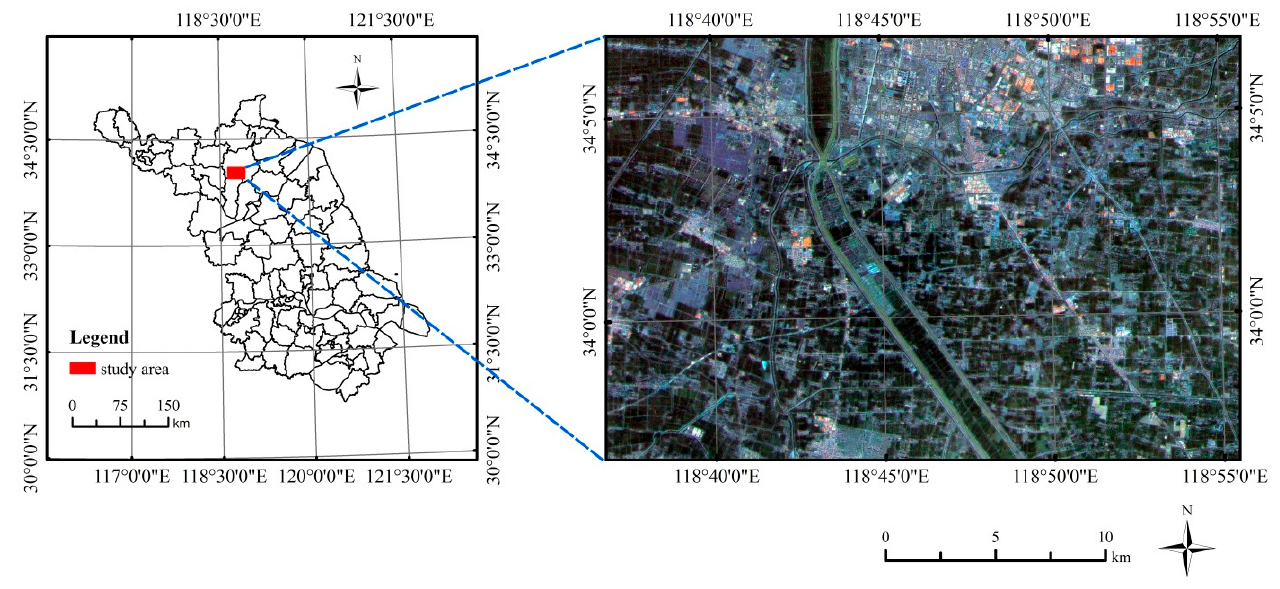
Figure 1. Study area of winter wheat planting area extraction based on object-oriented classification.